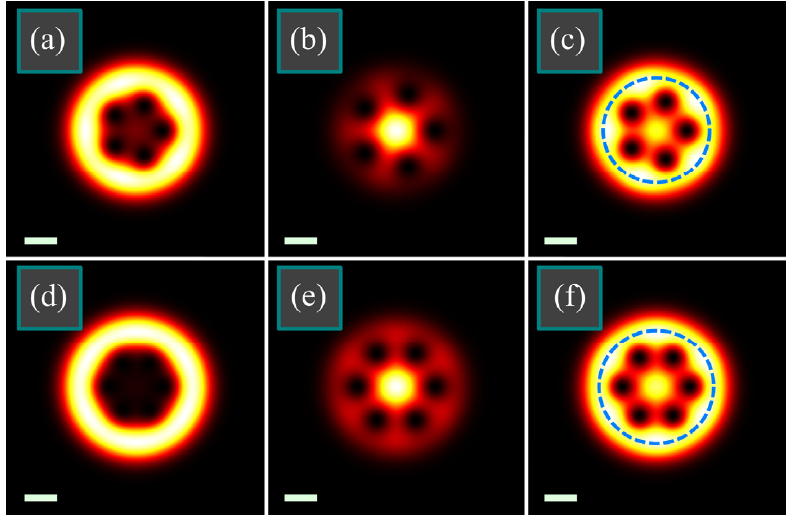
Figure 2. Intensity distributions of the light field (5) in the initial plane ( z = 0) for the following parameters: wavelength λ = 532 nm, Gaussian beam waist radius w 0 = 1 mm, number of polarization singularities m = 5 ( a – c ) and m = 6 ( d – f ), radius of the singularities circle a 0 = 800 µ m ( a , d ), a 0 = 1200 µ m ( b , e ), a 0 = 942 µ m ( c ), a 0 = 1041 µ m ( f ). Size of all figures is 8 × 8 mm 2 , scale mark in each figure denotes 1 mm. Blue dashed circles ( c , f ) denote the radius of the maximal peripheral intensity computed by Equation (20).